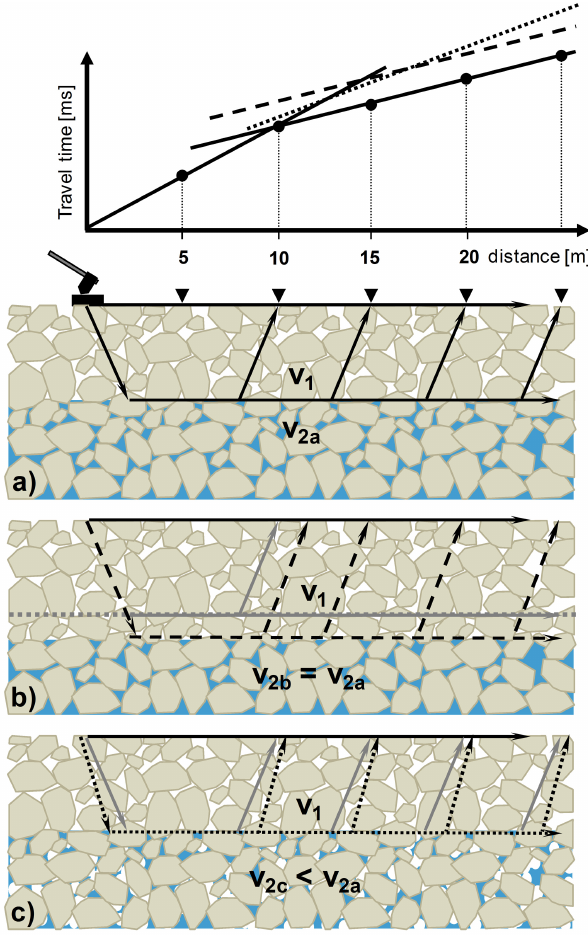
Fig. 1. Idealised principle of time-lapse refraction seismic based on (a) a two-layer subsurface model with a coarse-blocky unfrozen overburden with air-filled voids and a saturated rock-ice-matrix un- derneath. The lower panels illustrate the change of travel times as a consequence of (b) a vertical shift of the refractor (e.g. the sea- sonally varying interface between frozen and unfrozen conditions), and (c) altered ice (and air) contents within the lower layer causing changes in seismic velocity. The corresponding travel time curves for all three scenarios are given